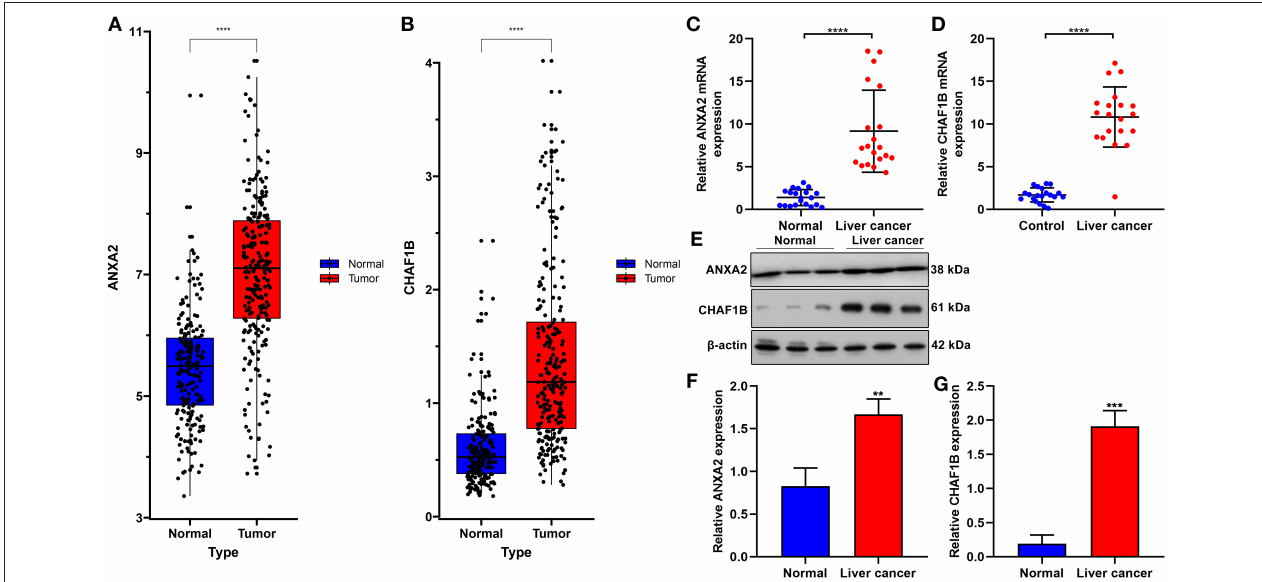
FIGURE 8 | Validation of ANXA2 and CHAF1B mRNAs in liver cancer tissues. (A,B) Box plots for ANXA2 and CHAF1B expressions in liver cancer and normal tissues from the ICGC database. (C,D) RT-qPCR and (E–G) western blot for ANXA2 and CHAF1B expressions in 20 paired liver cancer and normal tissue specimens. ** P < 0.01; *** P < 0.001; **** P <